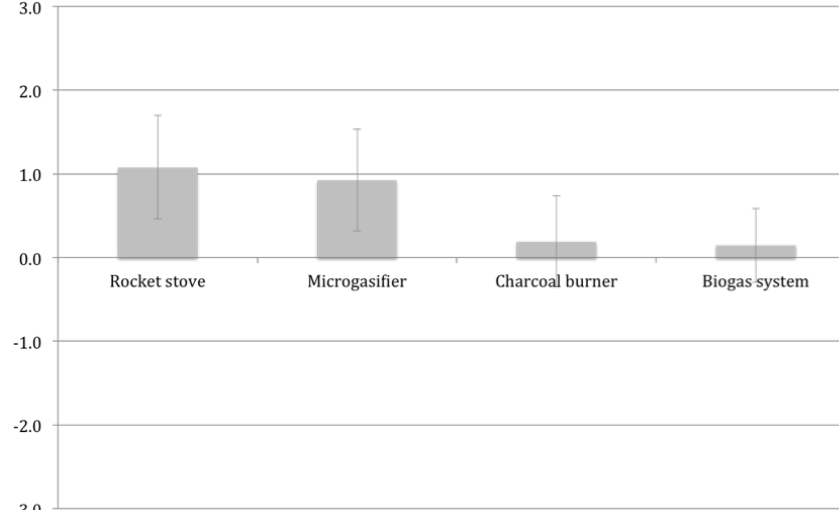
Figure 4. The average sustainability index (SI) of cooking alternatives analysed, presented as mean value of all participants and in ranked order. The SI-values range from − 10 to + 10 (cf. Table 4). Grey bars indicate the standard error of the mean